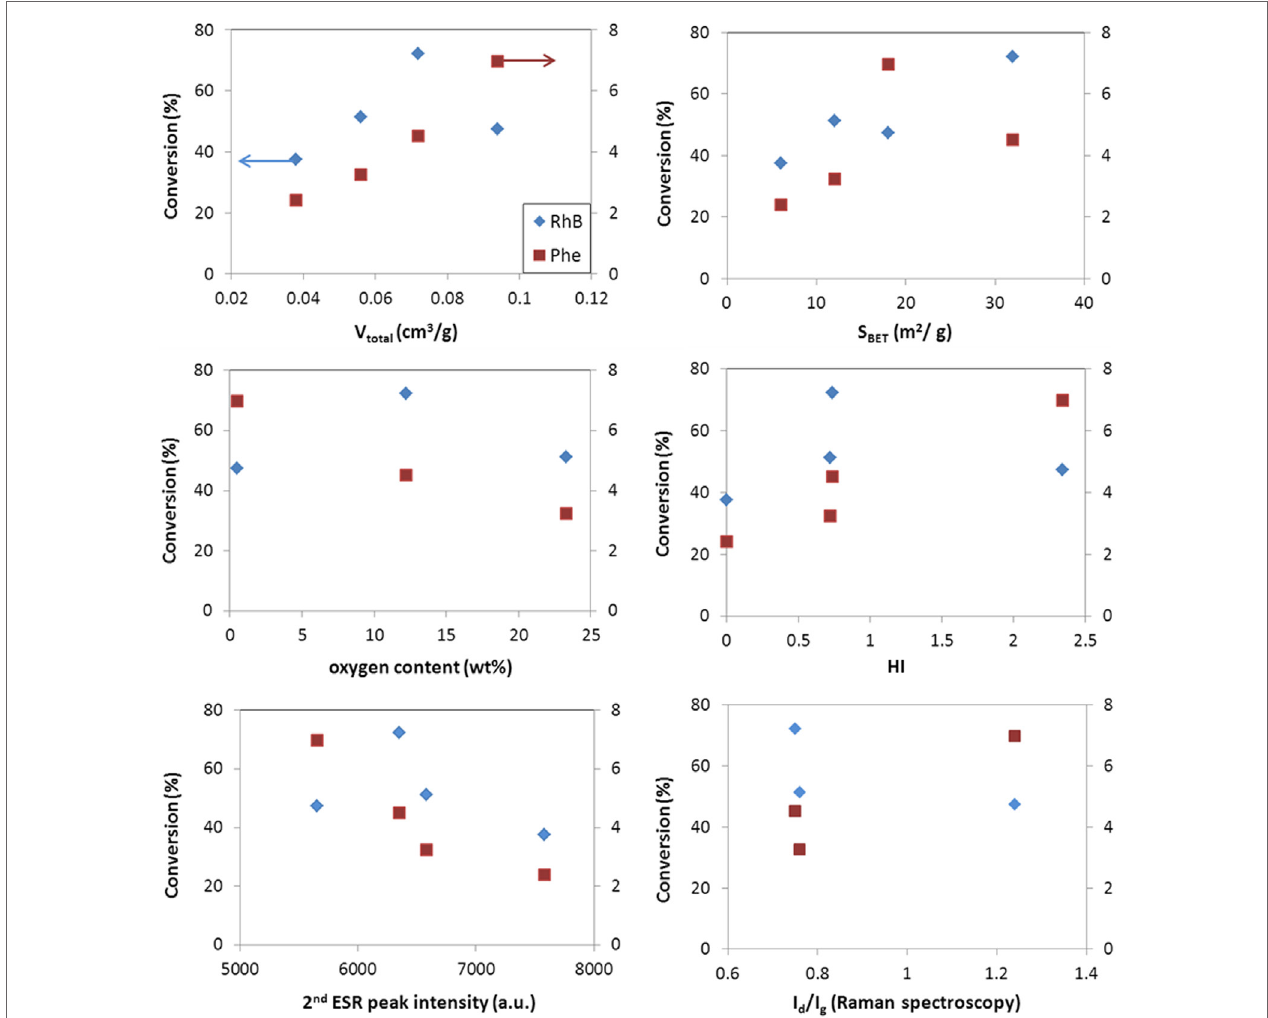
FigUre 5 | correlation of conversion values for phenol (right axis) and rhodamine (left axis) with selected characteristics of the WO 3 /carbon photocatalysts for a catalyst loading of 0.5 g/l .